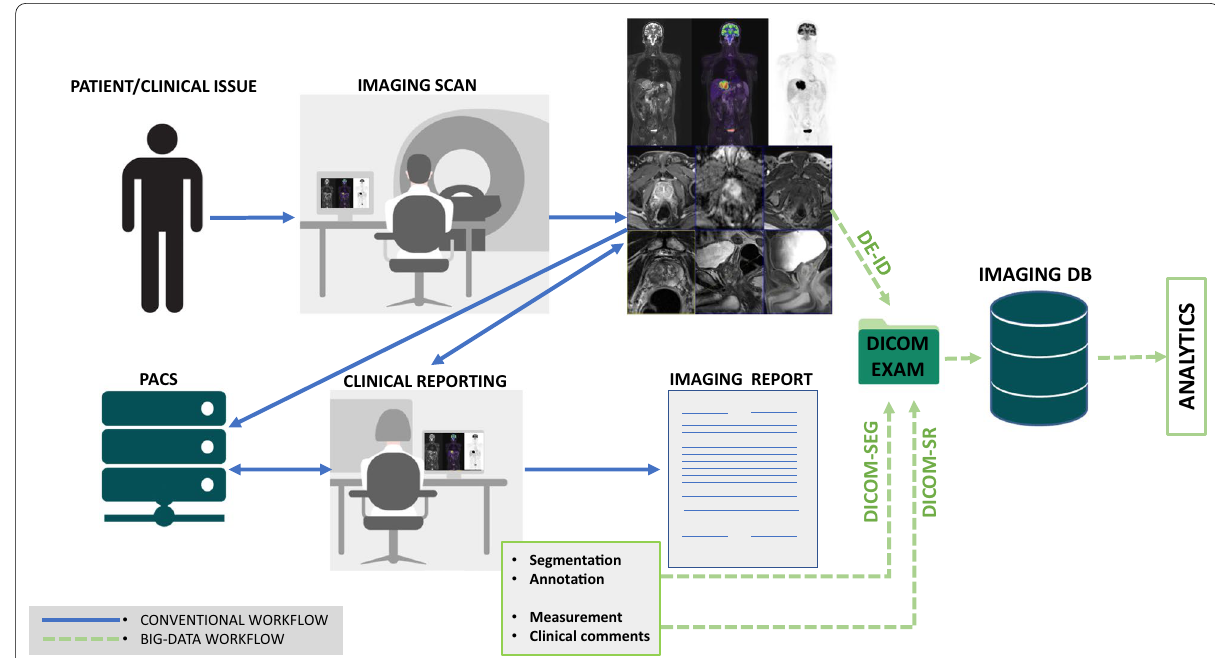
Fig. 1 Conventional radiological workflow and collection of information for big data analytics using specific DICOM tags. Blue arrows refer to the radiological workflow; green arrows refer to data collection for big data